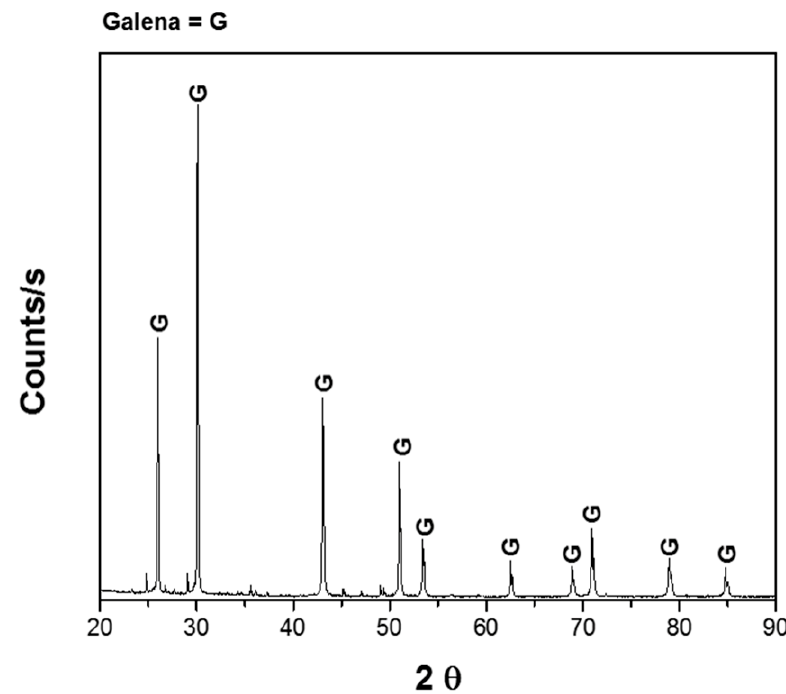
Figure 1. X-ray diffractogram of galena.